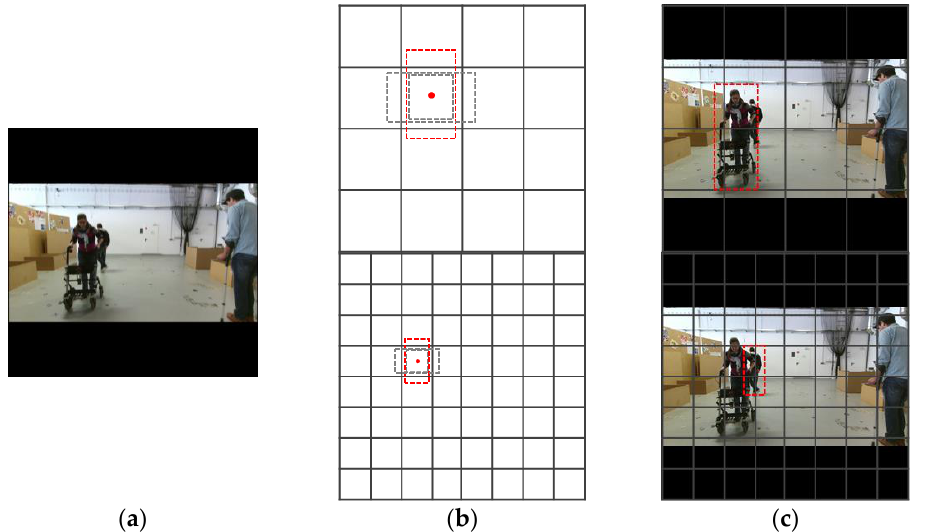
Figure A1. Example of how anchor boxes work at different scales. ( a ) Original padded image taken from the MobilityAids dataset. ( b ) Anchor boxes at two different scales. The 4 × 4 grid, at the top, captures bigger objects, while the 8 × 8 grid, at the bottom, captures finer details. ( c ) The anchor boxes are offset and scaled to fit the person at each scale.